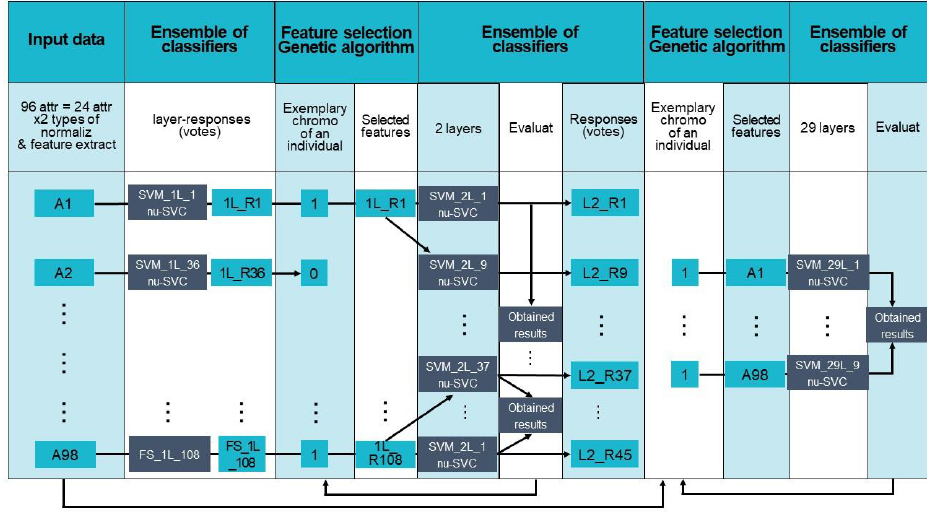
Figure 8. Schematic overview of the main part of the deep genetic hierarchical network of learners. Source: Pławiak et al. [23].